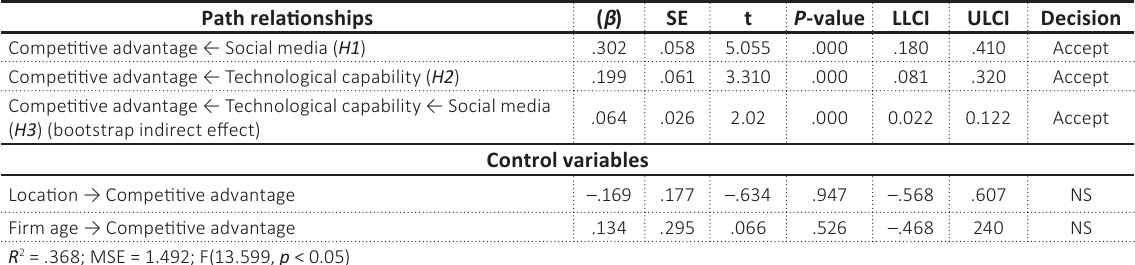
Table 3. Direct and indirect relationships between